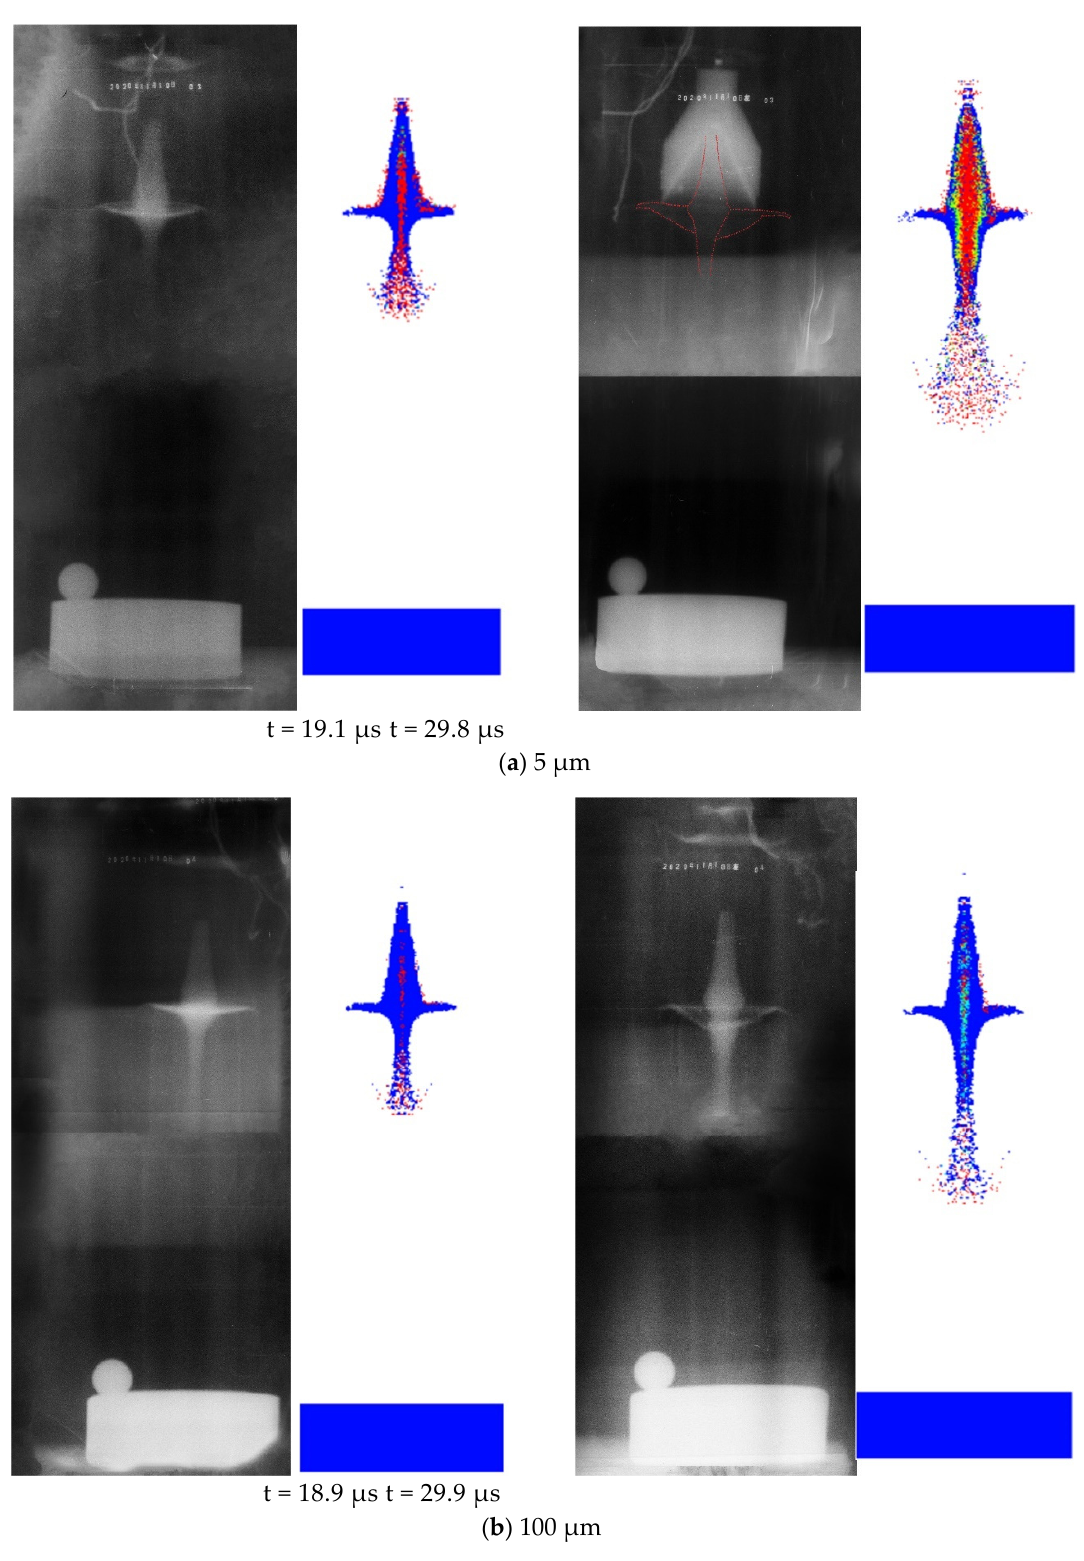
Figure 11. Shape contrast of shaped charge penetration.